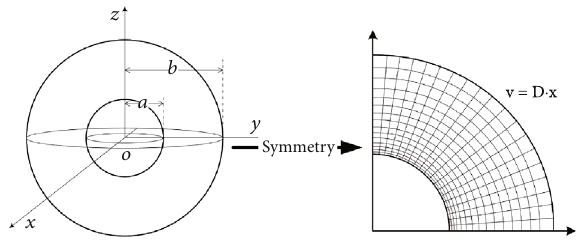
Figure 6: Initial mesh of the hollow sphere